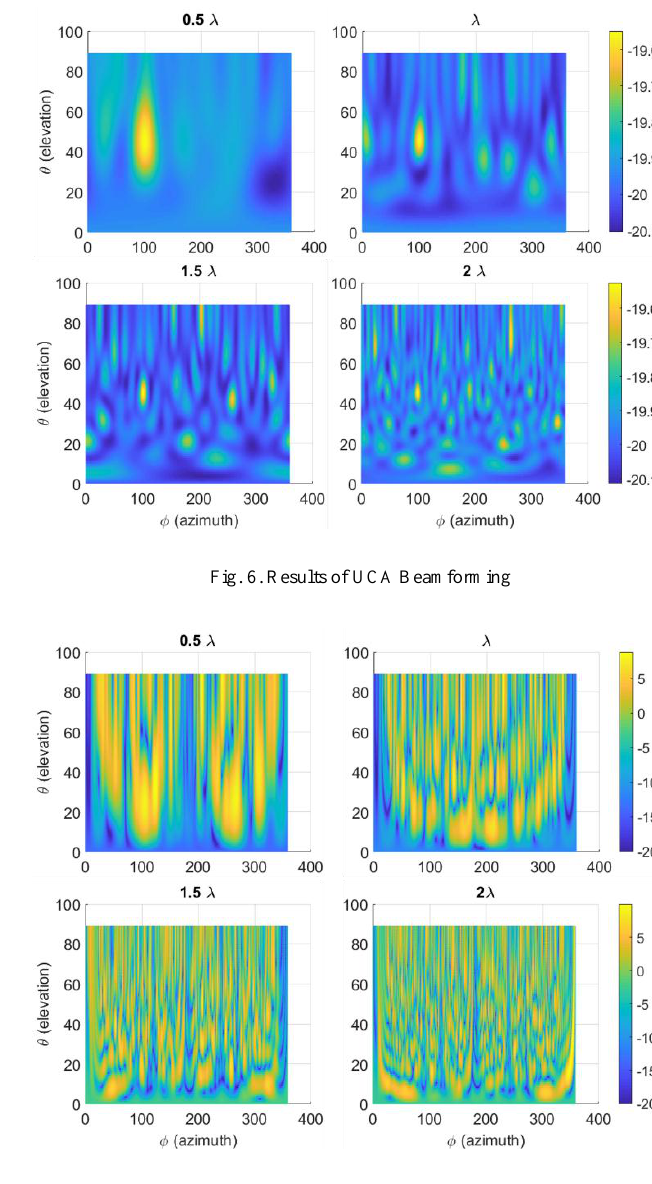
Fig. 7. Results of UPA